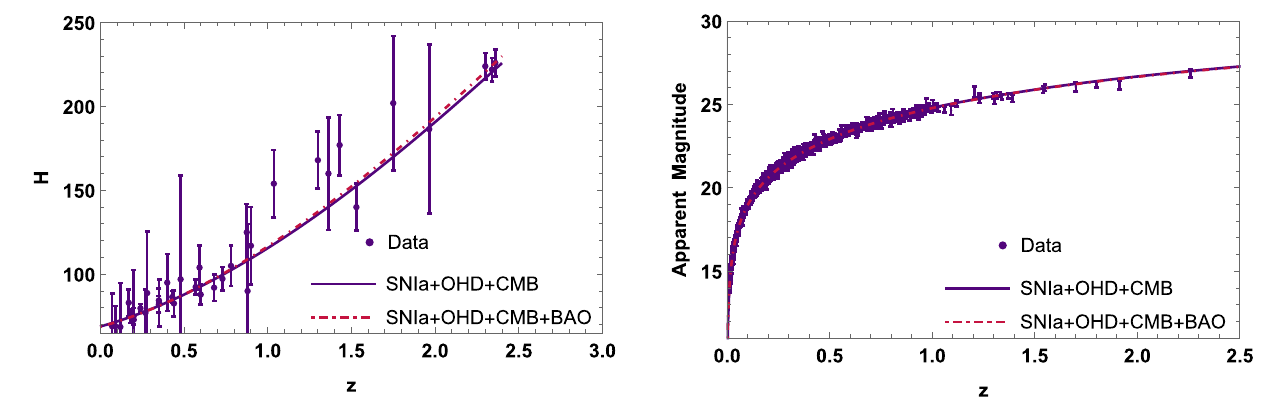
Fig. 2 The evolution of Hubble parameter with redshift for the best estimated values of the model parameters using the fourth and sixth datasets, compared with H ( z ) data points